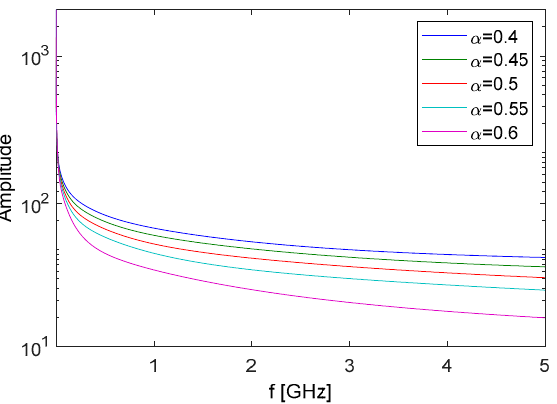
Figure 6. Amplitude of the rational approximation G ( ω ) for different values of α .